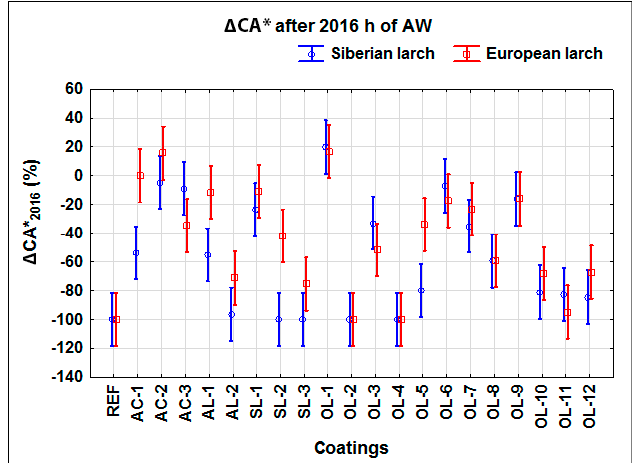
Figure 8. Changes in the water contact angle on the tested coatings in percentages after 2016 h of artificial weathering evaluated as 95% two-side confidence intervals. The Tukey HSD test shows that the differences in the analysed values were statistically significant ( p -value < 0.05) for coating systems AC-1 and SL-2.